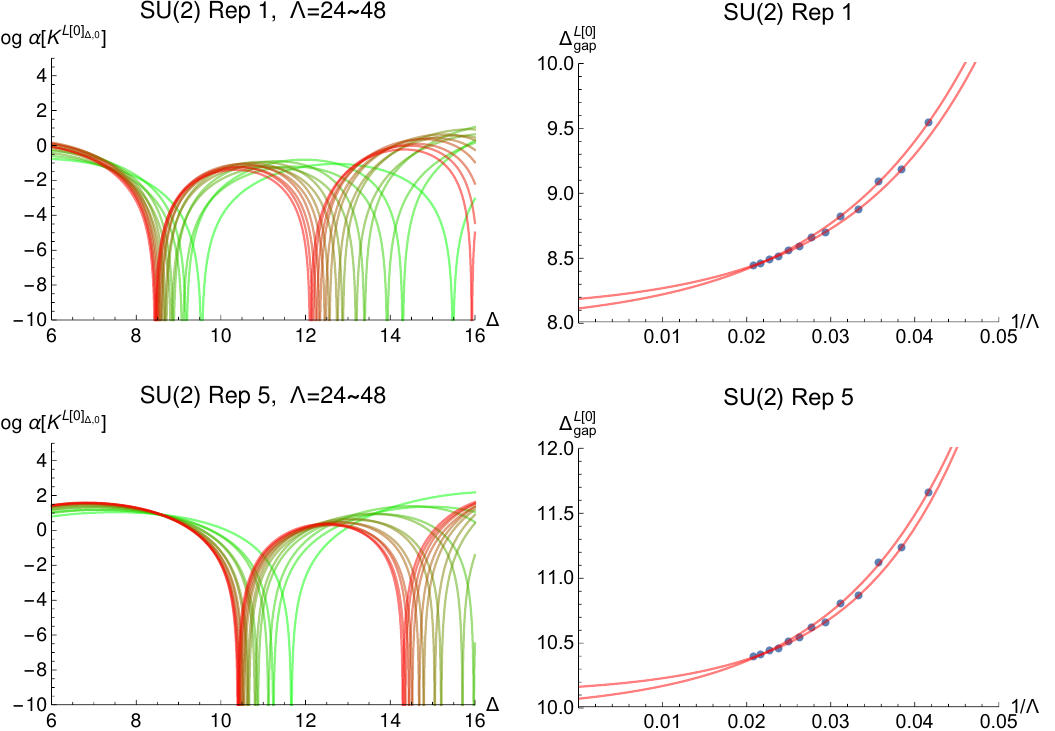
Figure 2 . Left: the extremal functional optimizing the lower bound on C J acted on the contribution of the spin-zero long multiplet to the crossing equation, (cid:11) E [ K L [0] (cid:1) ; 0 ], in the 1 and 5 channels of the SU(2) (cid:13)avor, plotted in logarithmic scale. Increasing derivative orders (cid:3) = 24 ; 26 ; : : : ; 48 are shown from green to red. Right: the gap (lowest scaling dimension) in the spectrum of long multiplets in each channel at di(cid:11)erent (cid:3). Also shown are the extrapolations to (cid:3) ! 1 using the ansatz (8.1), for (cid:3) 2 4 Z and (cid:3) 2 4 Z + 2, separately.